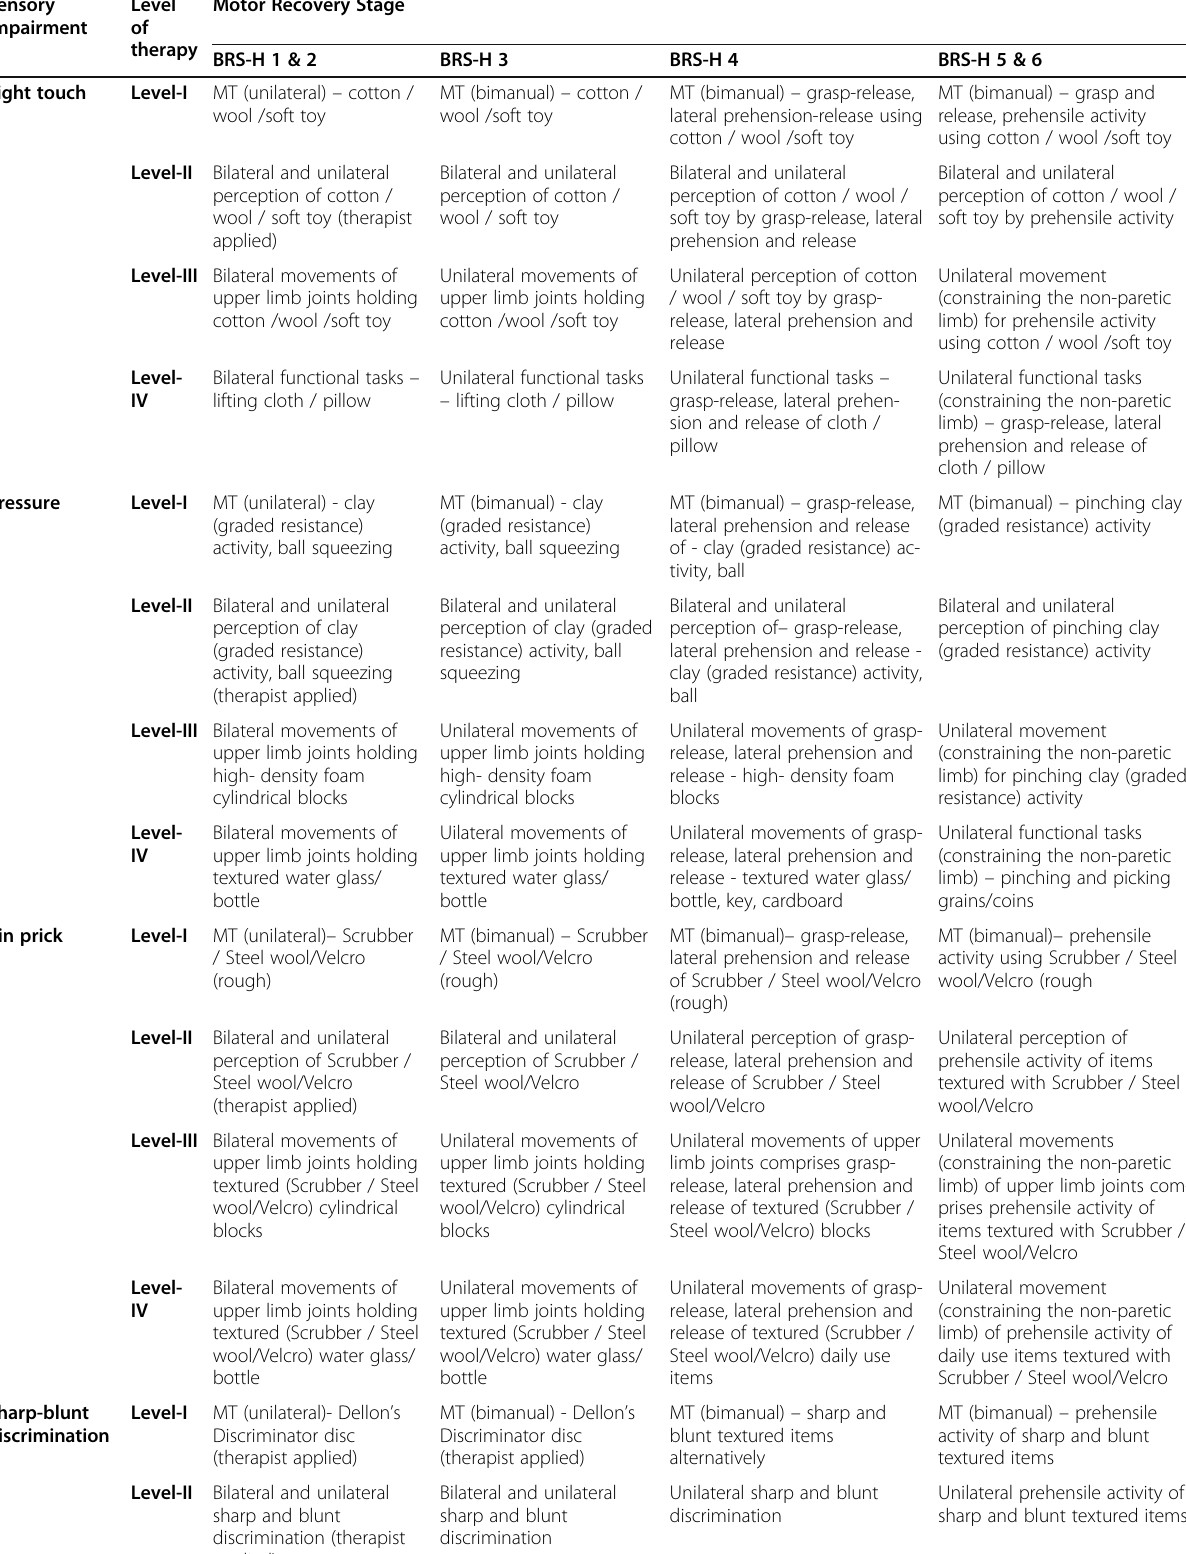
Table 1 Experimental intervention as per the type of sensory impairment and motor recovery stage of the hand Sensory